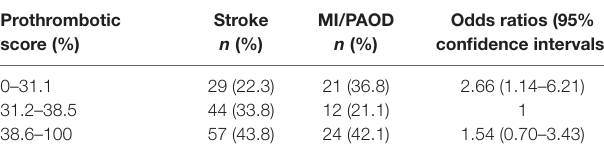
TaBle 2 | Logistic regression analysis of the tertiled prothrombotic score (computed as the percentage of mutations per patient) of stroke patients with complete data sets ( n = 130) compared to patients with either myocardial infarction (MI) or PAOD and complete data sets ( n = 57).